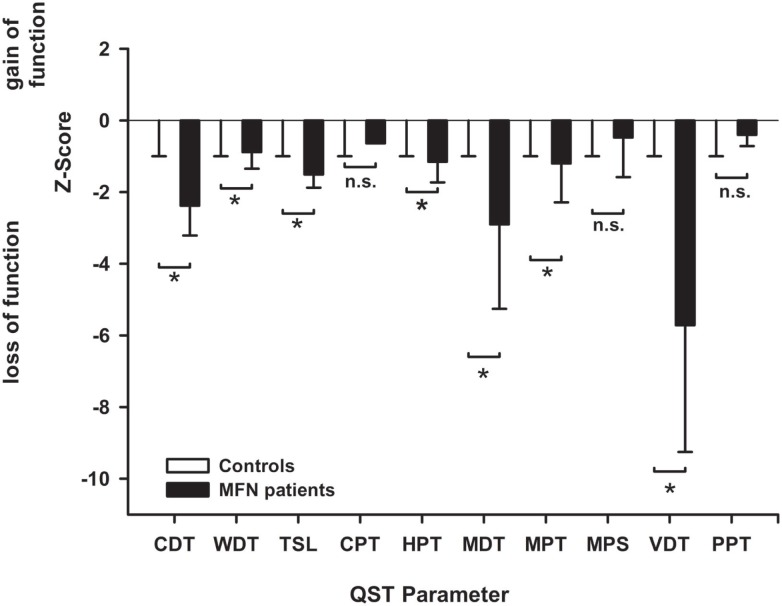
Sensory profile of patients with mixed fiber neuropathy (MFN) and controls obtained by quantitative sensory testing (QST). The bar graphs depict the z-scores at the dorsal foot in MFN patients contrasted to healthy control subjects. Healthy controls are shown by white bar graphs, whereas MFN patients are represented by black bar graphs. The z-scores of healthy controls are zero with a SD of one due to the calculation of z-score (see methods). This is the reason why the white bar graphs are not seen and disappear in the zero-line. z-scores < 0 indicate a loss of function, z-scores > 0 exhibits a gain of function. MFN displays impaired cold (CDT), warm (WDT), mechanical (MDT), and vibration detection thresholds (VDT) as well as cold pain thresholds (CPT) compared to controls (p < 0.05) indicating deafferentation of small and large fibers. NB: Patients’ CPT was 10°C which is the cut-off value for CPT assessment during QST. Therefore, the CPT value does not have an error bar. Abbreviations: CPT, cold pain threshold; HPT, heat pain threshold; ability to detect temperature changes (thermal sensory limen, TSL); MPT, mechanical pain threshold; MPS, mechanical pain sensitivity; PPT, pressure pain threshold (PPT); VDT, vibration detection threshold. Data are expressed as mean and SD.*p < 0.05.